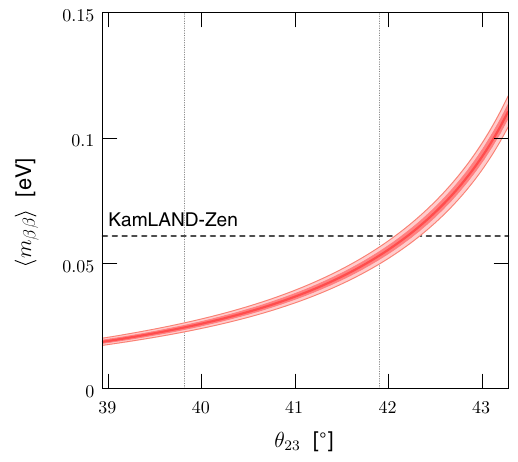
(cid:2) m i < 0 . 23 eV i